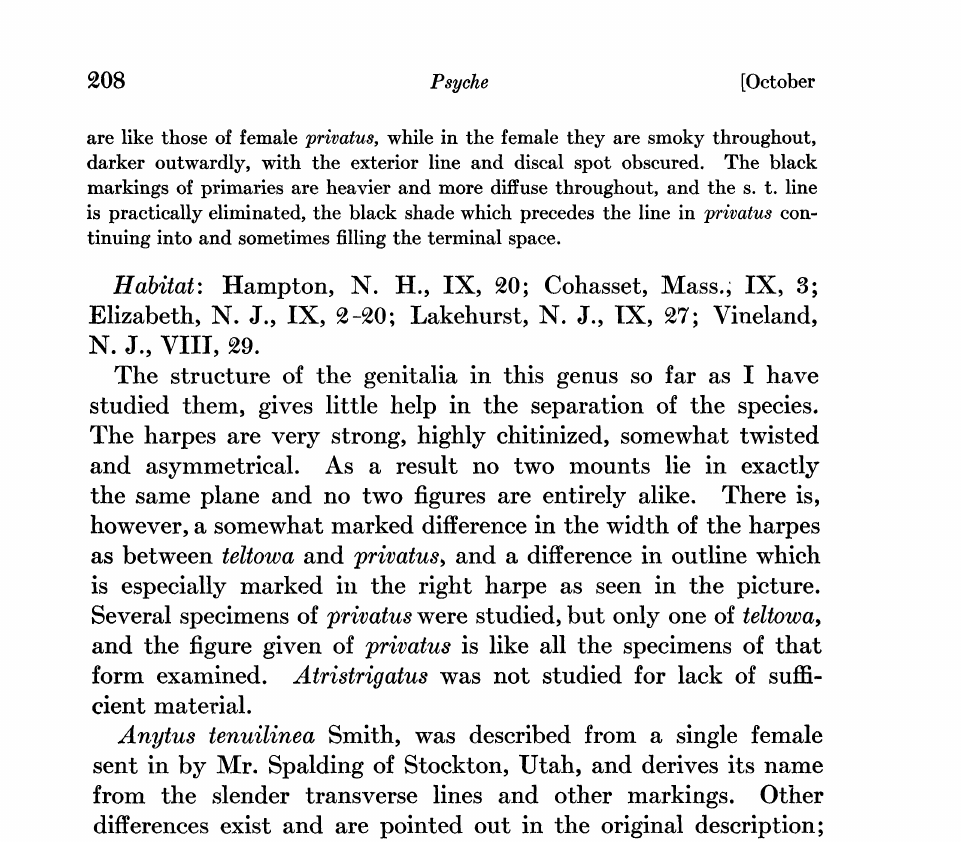
are like those of female privatus, while in the female they are smoky throughout, darker outwardly, with the exterior line and discal spot obscured. The black markings of primaries are heavier and more diffuse throughout, and the s. t. line is practically eliminated, the black shade which precedes the line in privatus con- tinuing into and sometimes filling the terminal